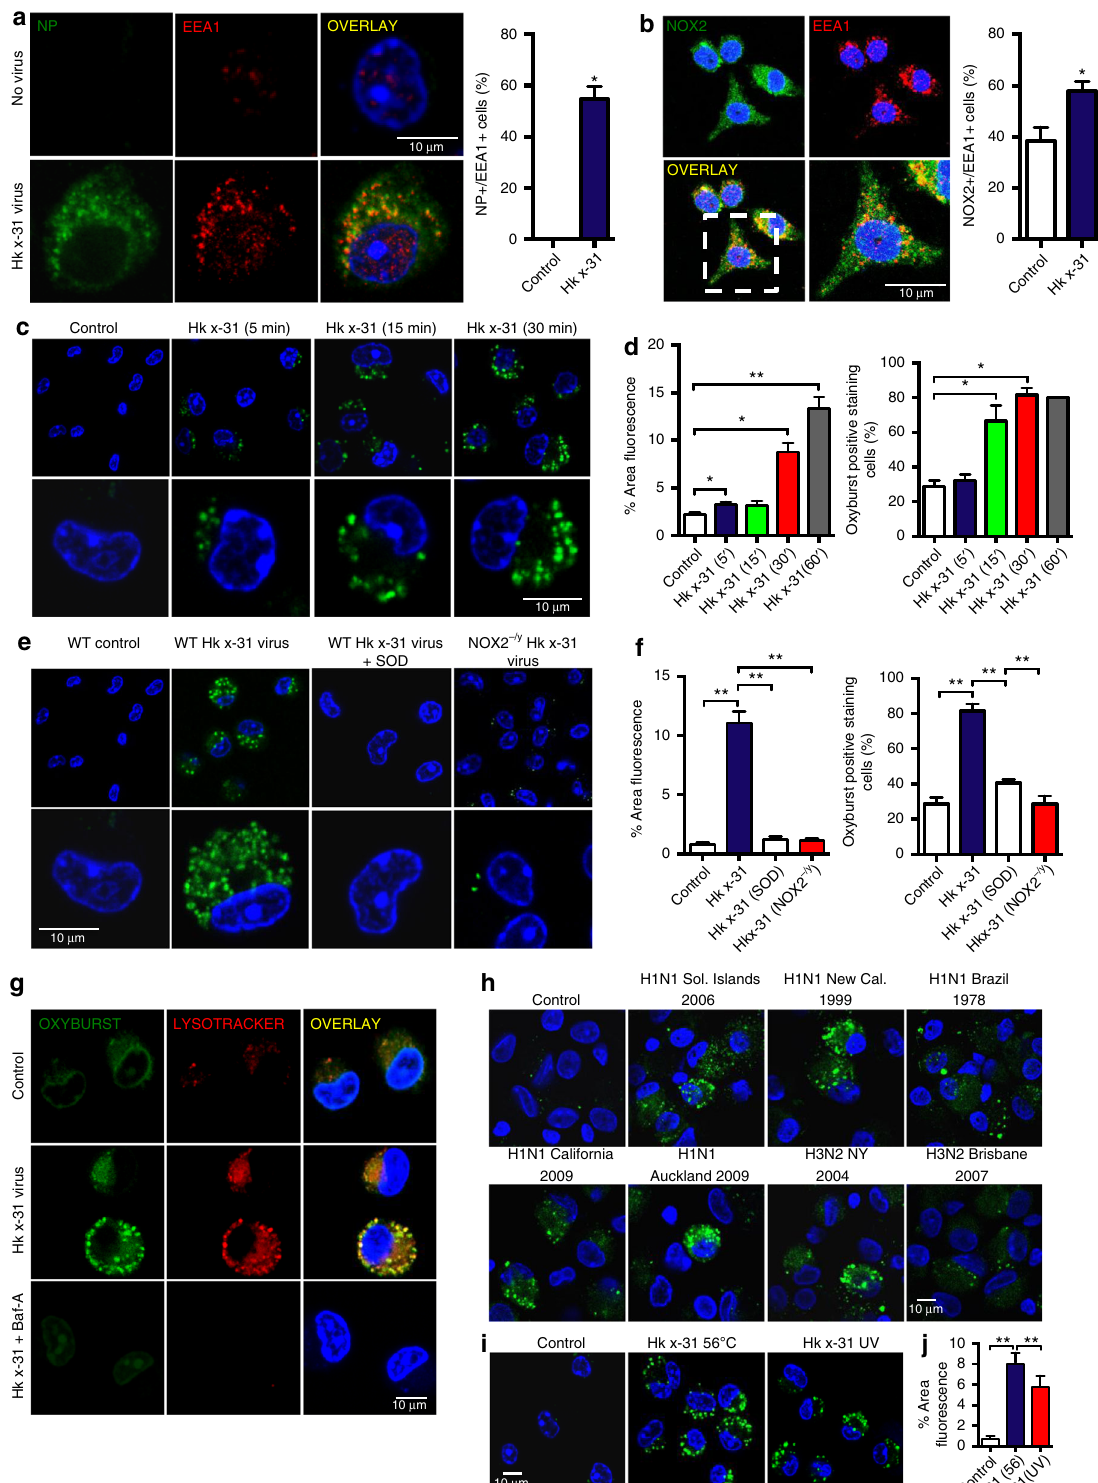
(Fig. 1e, f, Supplementary Fig. 2h, i). Internalization of in fl uenza